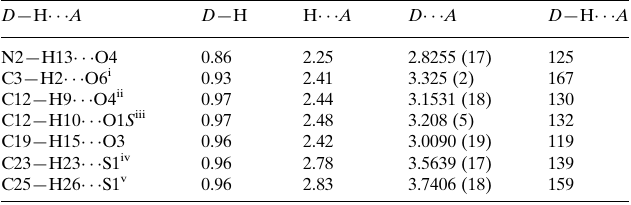
Bruker APEXII diffractometer Absorption correction: multi-scan